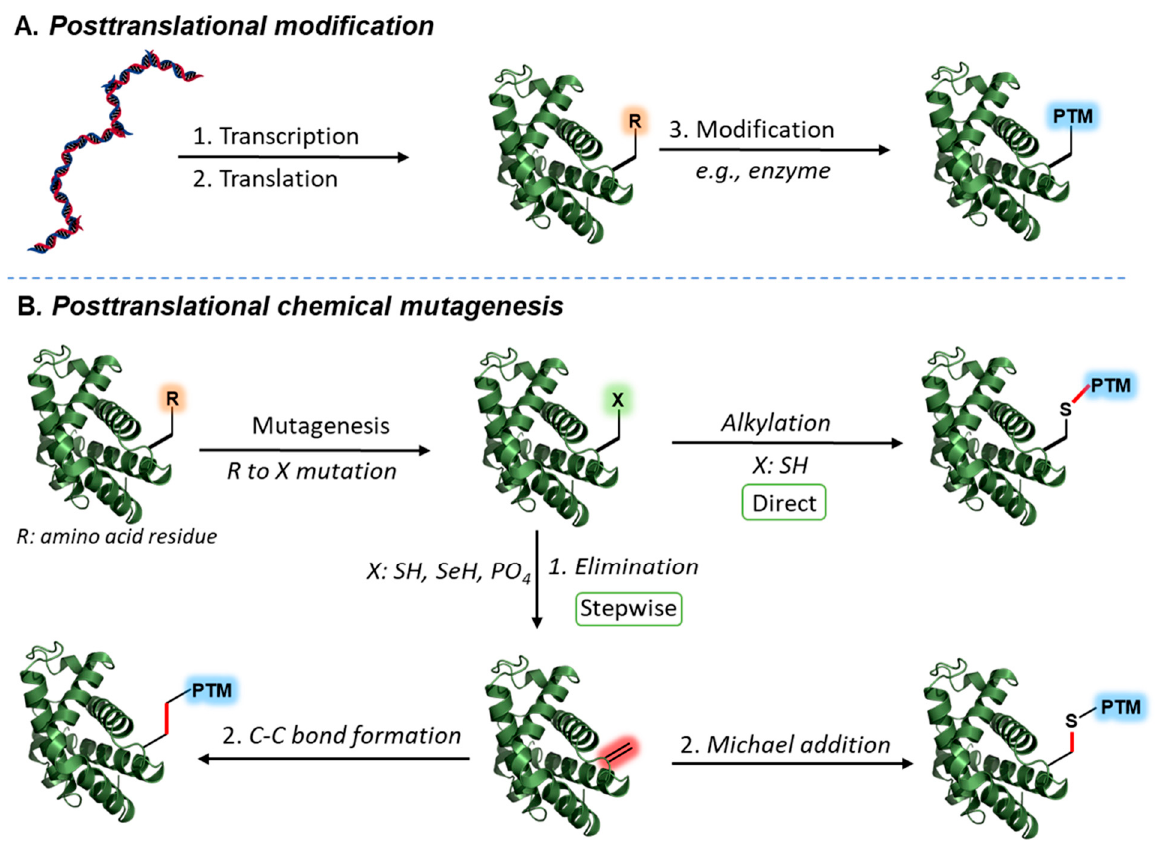
Figure 1. Enzymatic and synthetic posttranslational modification of proteins. ( A ) Posttranslational modification in nature via enzymes. ( B ) Chemoselective installation of posttranslational modification mimics via S -alkylation of Cys or dehydroalanine (Dha) functionalization via Michael addition or carbon–carbon bond formation.